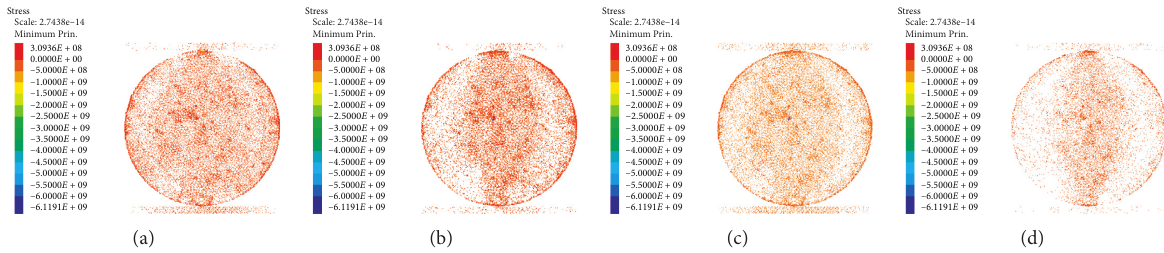
Figure 26: Splitting stress cloud of 45 ° bedding shale with different contact cohesion. (a) 0.8 times. (b) 1 time. (c) 1.2 times. (d) 1.5 times.